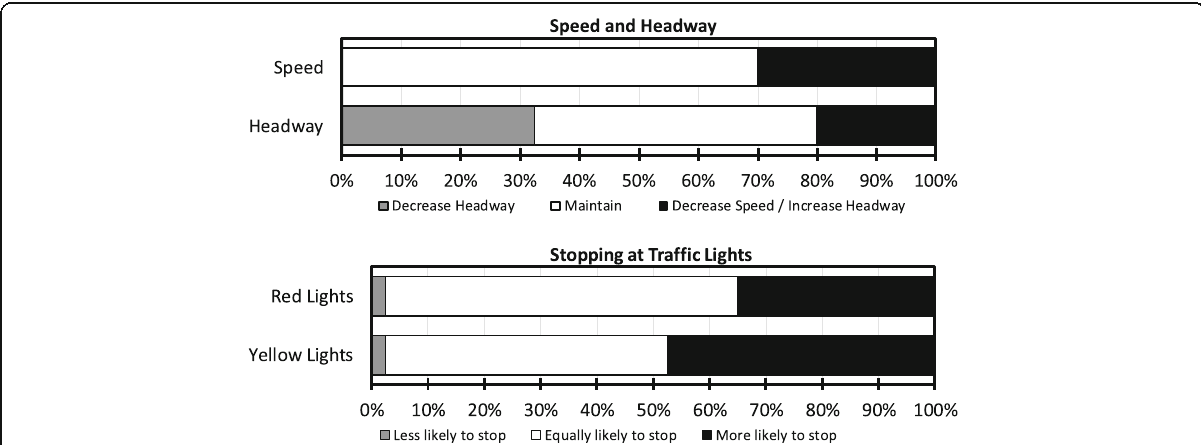
Fig. 5 Self-reported driver behavior when driving past roadside memorials. Note that white shaded areas represent no behavioral change in response to memorials; black represents those reporting positive safety-related behaviors (slowing, stopping) and gray indicates less safe